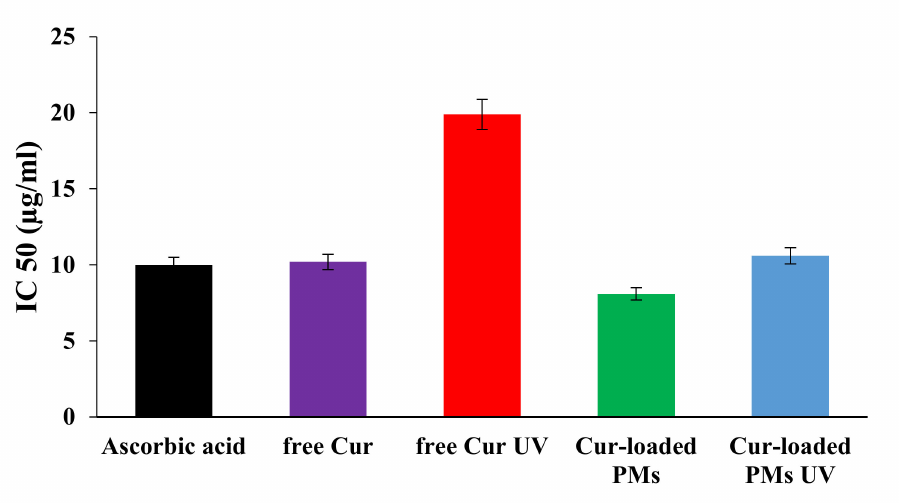
Figure 3. IC50 values for ascorbic acid, and non-irradiated and UV-irradiated free Cur and Cur-loaded PMs.